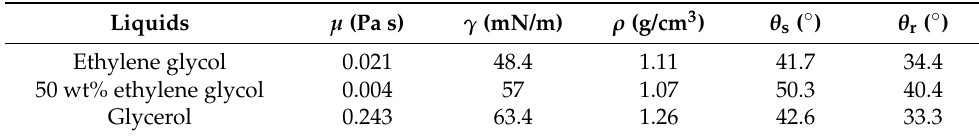
Table 1. Experimental liquids and physical properties.